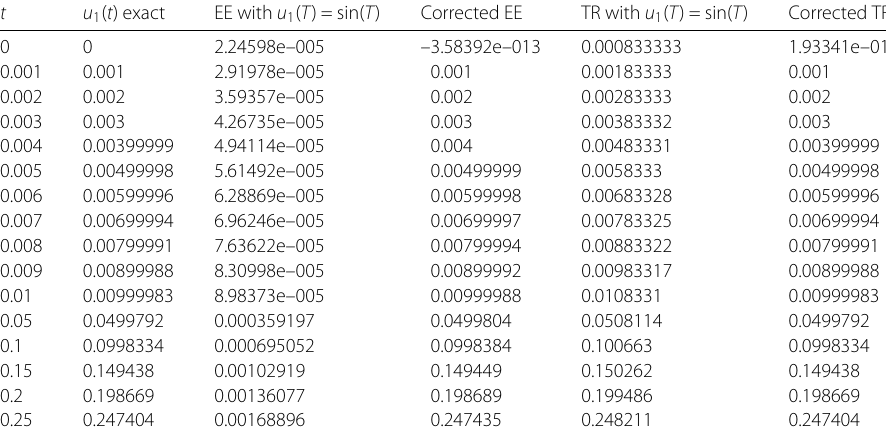
Table 4 Kneser’s differential equation: Computation of Sinus solution for φ ( t ) = 0